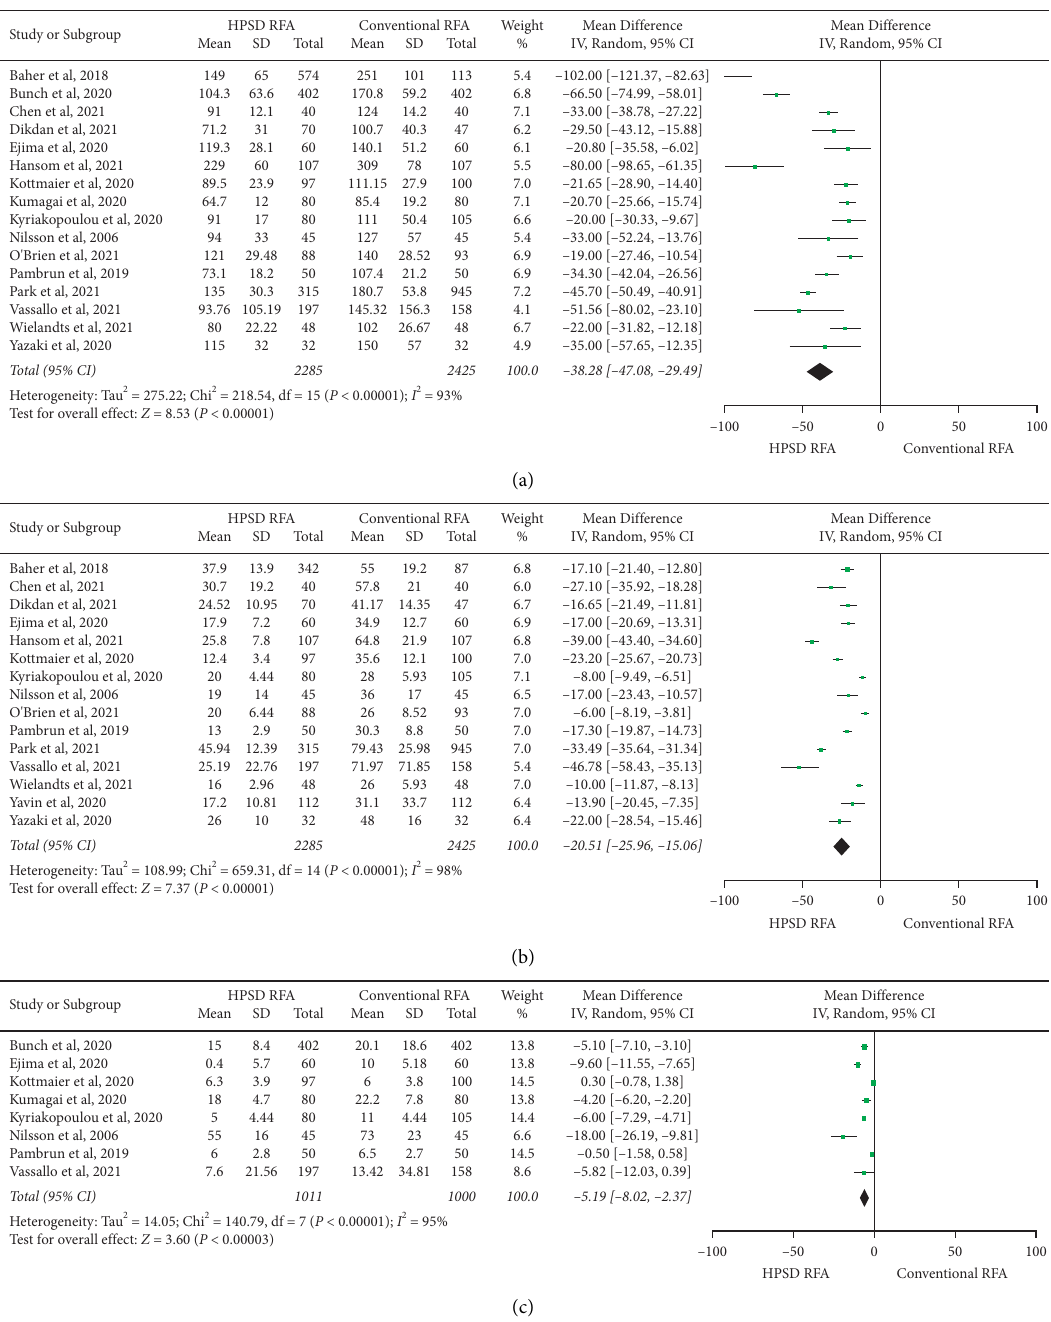
Figure 2: Forest plots of the primary pooled analysis demonstrating the effect of high-power short-duration RFA vs. conventional RFA in patients with atrial fibrillation. Data are mean duration and standard deviation in each group and weighted mean difference. )e horizontal line is the 95% CI. )e diamond shape is the pooled mean difference of all studies. CI: confidence interval; RFA: radiofrequency ablation. (a) Total procedure duration. (b) Total RF duration. (c) Total fluoroscopy